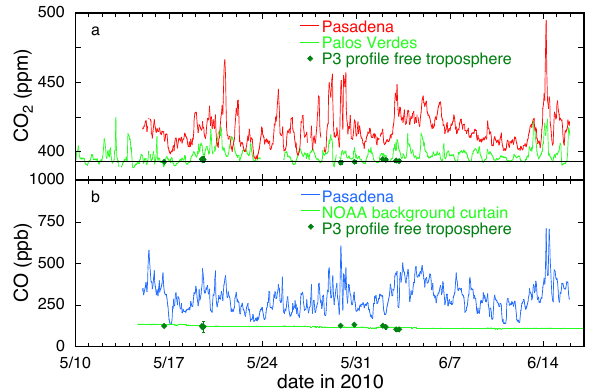
Fig. A2. (a) Time series for CO 2 for the period of the CalNex- LA campaign comparing measurements in Pasadena with those from Palos Verdes Peninsula, on a hillside overlooking the ocean. The average daily minimum CO 2 mixing ratio in Palos Verdes of 393.1ppm, indicated by the horizontal black line, was used for the CO 2 background in all calculations. (b) Time series for CO in Pasadena compared with time-varying free-tropospheric CO from the NOAA Pacific boundary curtain, showing good agreement with P3 vertical profiles over the Pasadena